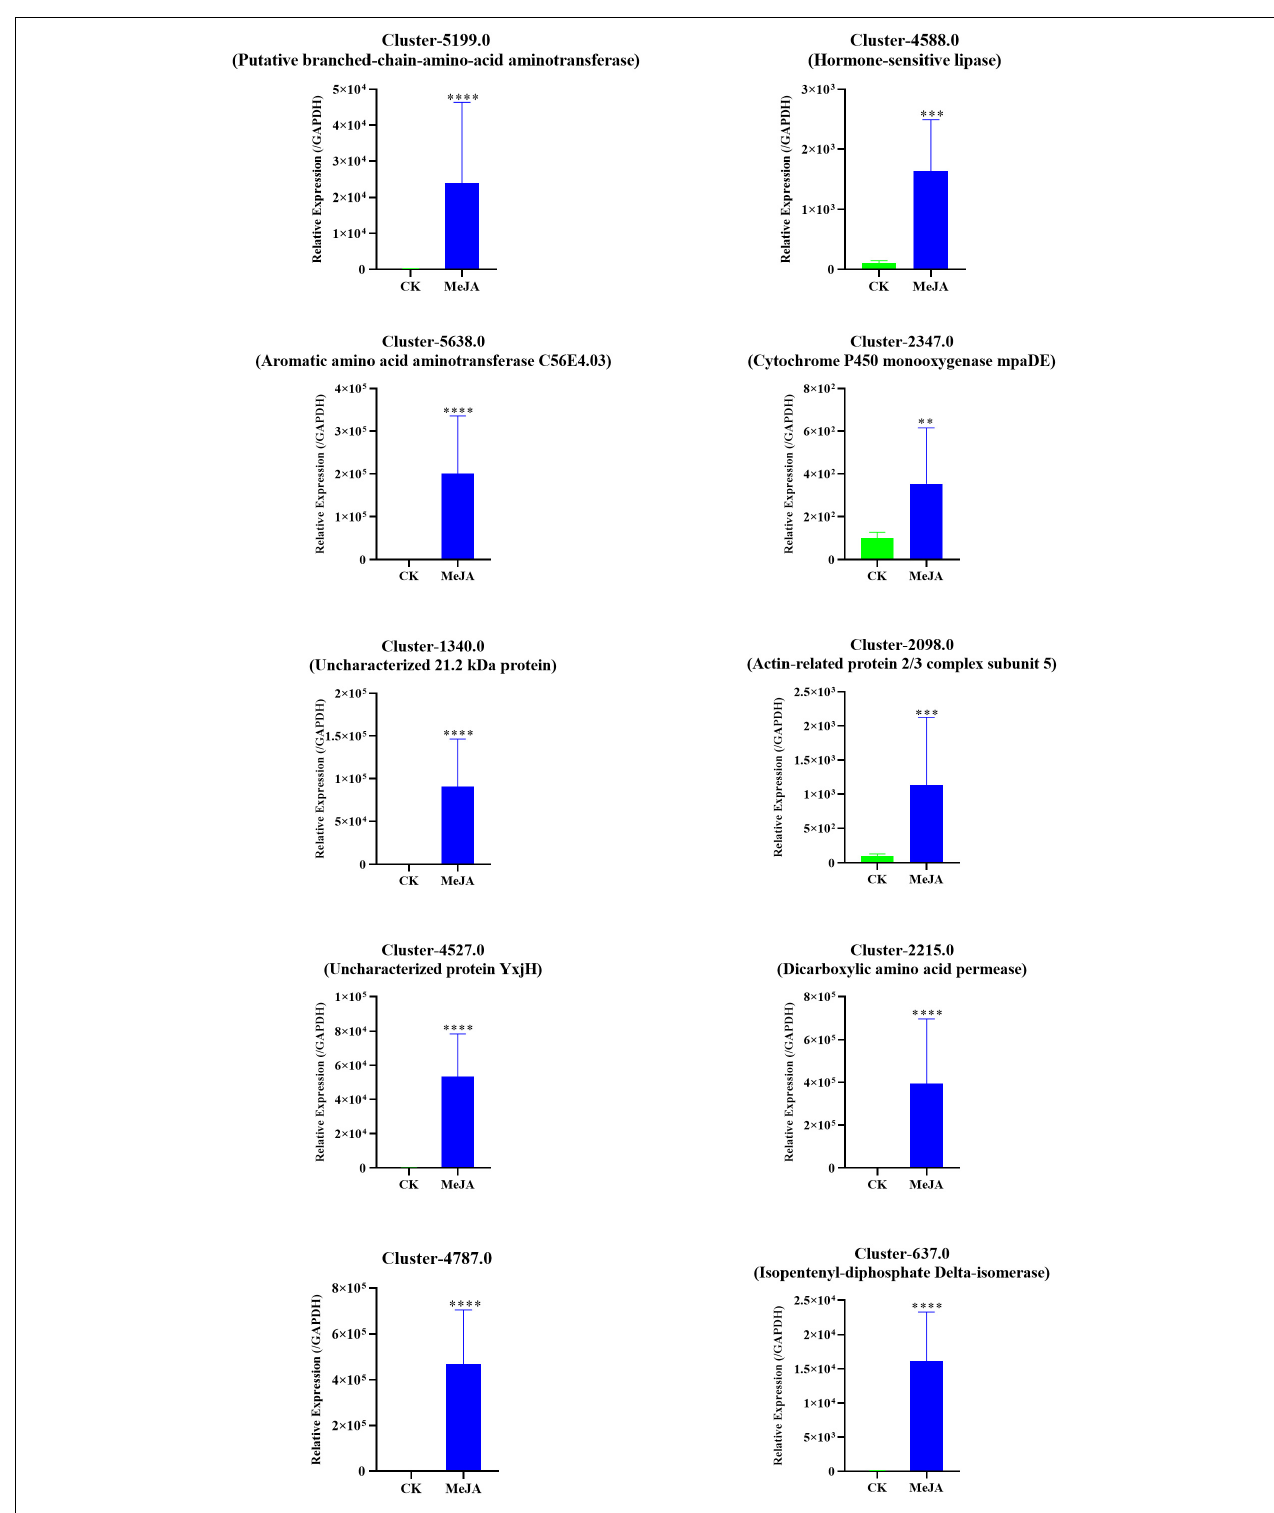
FIGURE 7 | qRT-PCR verification of the RNA-seq data of 10 selected DEGs in the MeJA treatment group and Control. The related expression levels of the key genes involved in the MeJA-induced accumulation of alkaloids in MD33. The expression level of MeJA changed significantly between MeJA and control group. ∗∗ p < 0.01, ∗∗∗ p < 0.001, ∗∗∗∗ p <